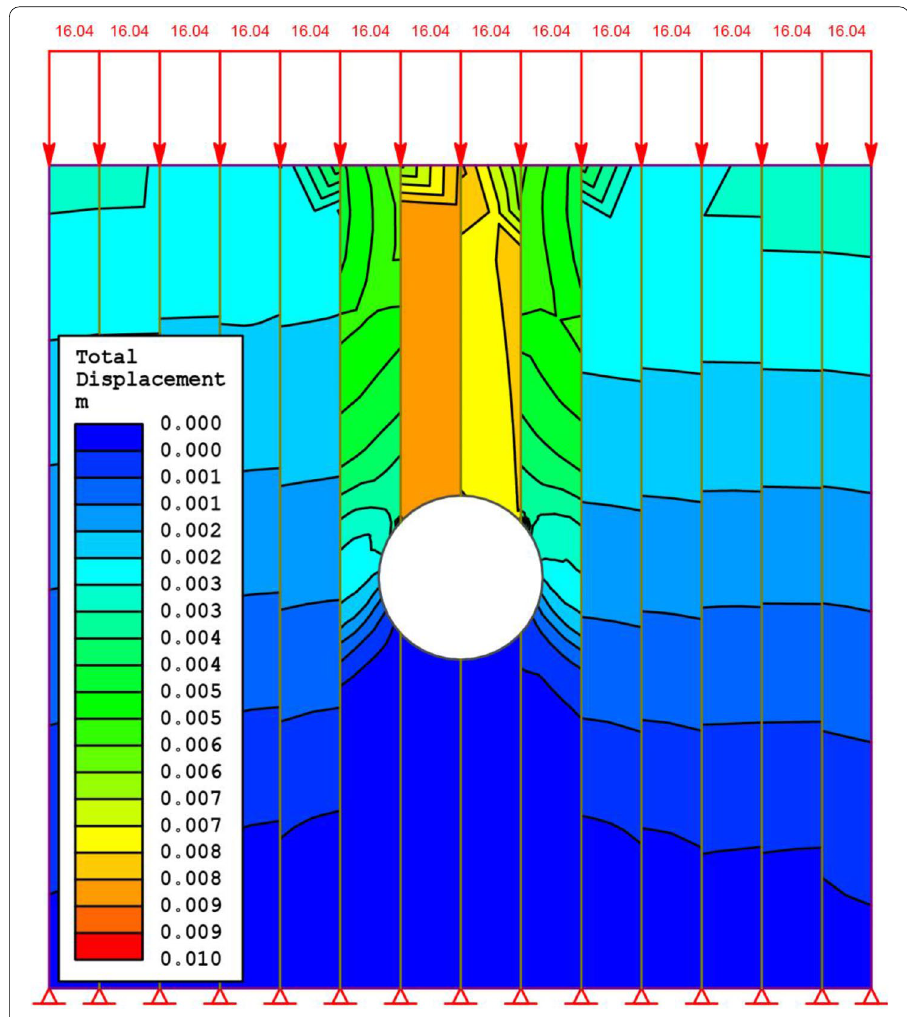
Fig. 17 Total displacement contour in vertically jointed